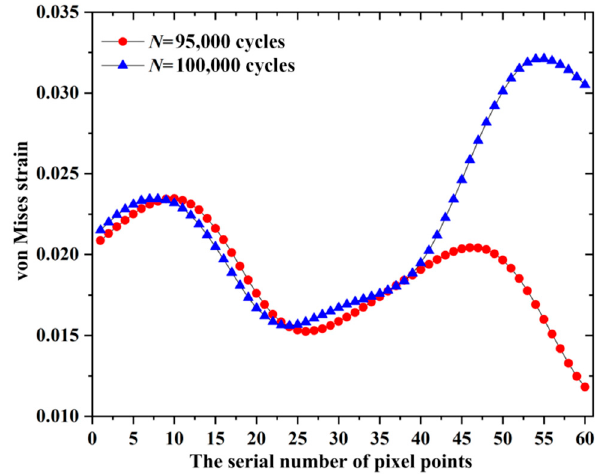
Figure 11. von Mises strain values of the dotted line in Figure 10.